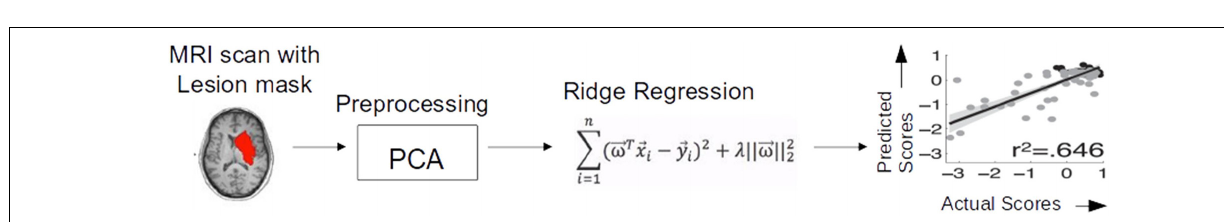
FIGURE 1 | Steps involved in the prediction of behavioral outcome in stroke patients from 3D lesion images. Conventional machine learning methods typically rely on data preprocessing and feature selection, which are dispensed with in deep convolutional neural networks.